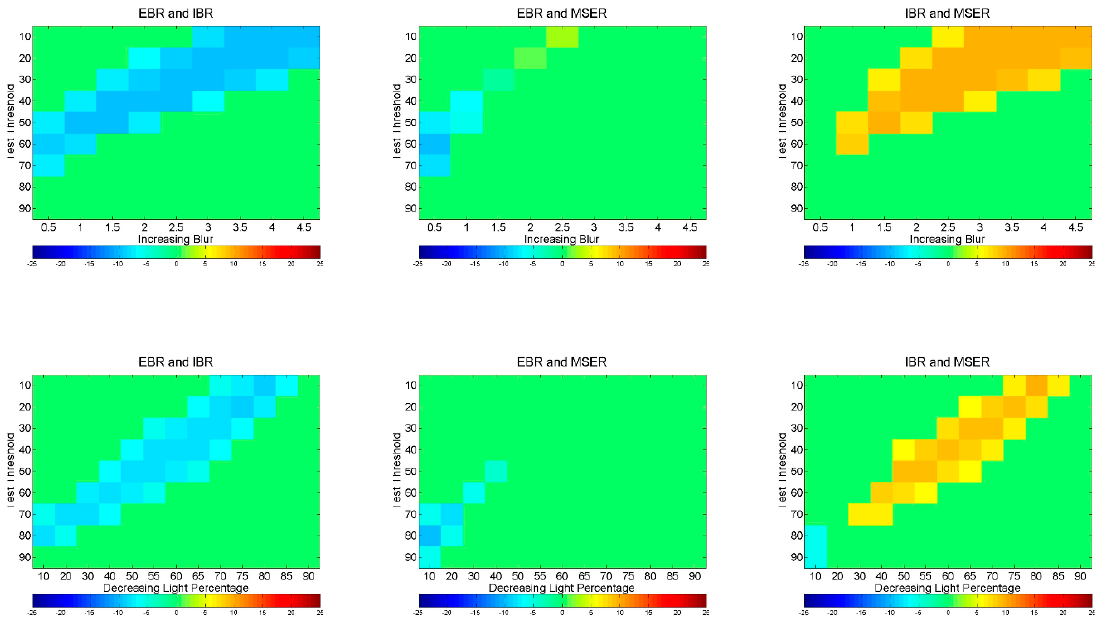
Figure 26. Results of EBR, MSER and IBR for remote sensing images under blur and light changes showing Z -scores obtained; positive Z -scores indicate that the first detector is better than the second whereas negative values show the converse.